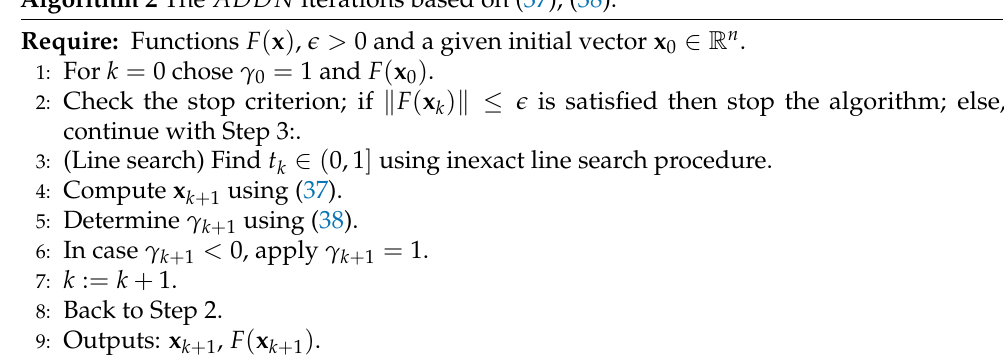
Algorithm 2 The ADDN iterations based on (37),